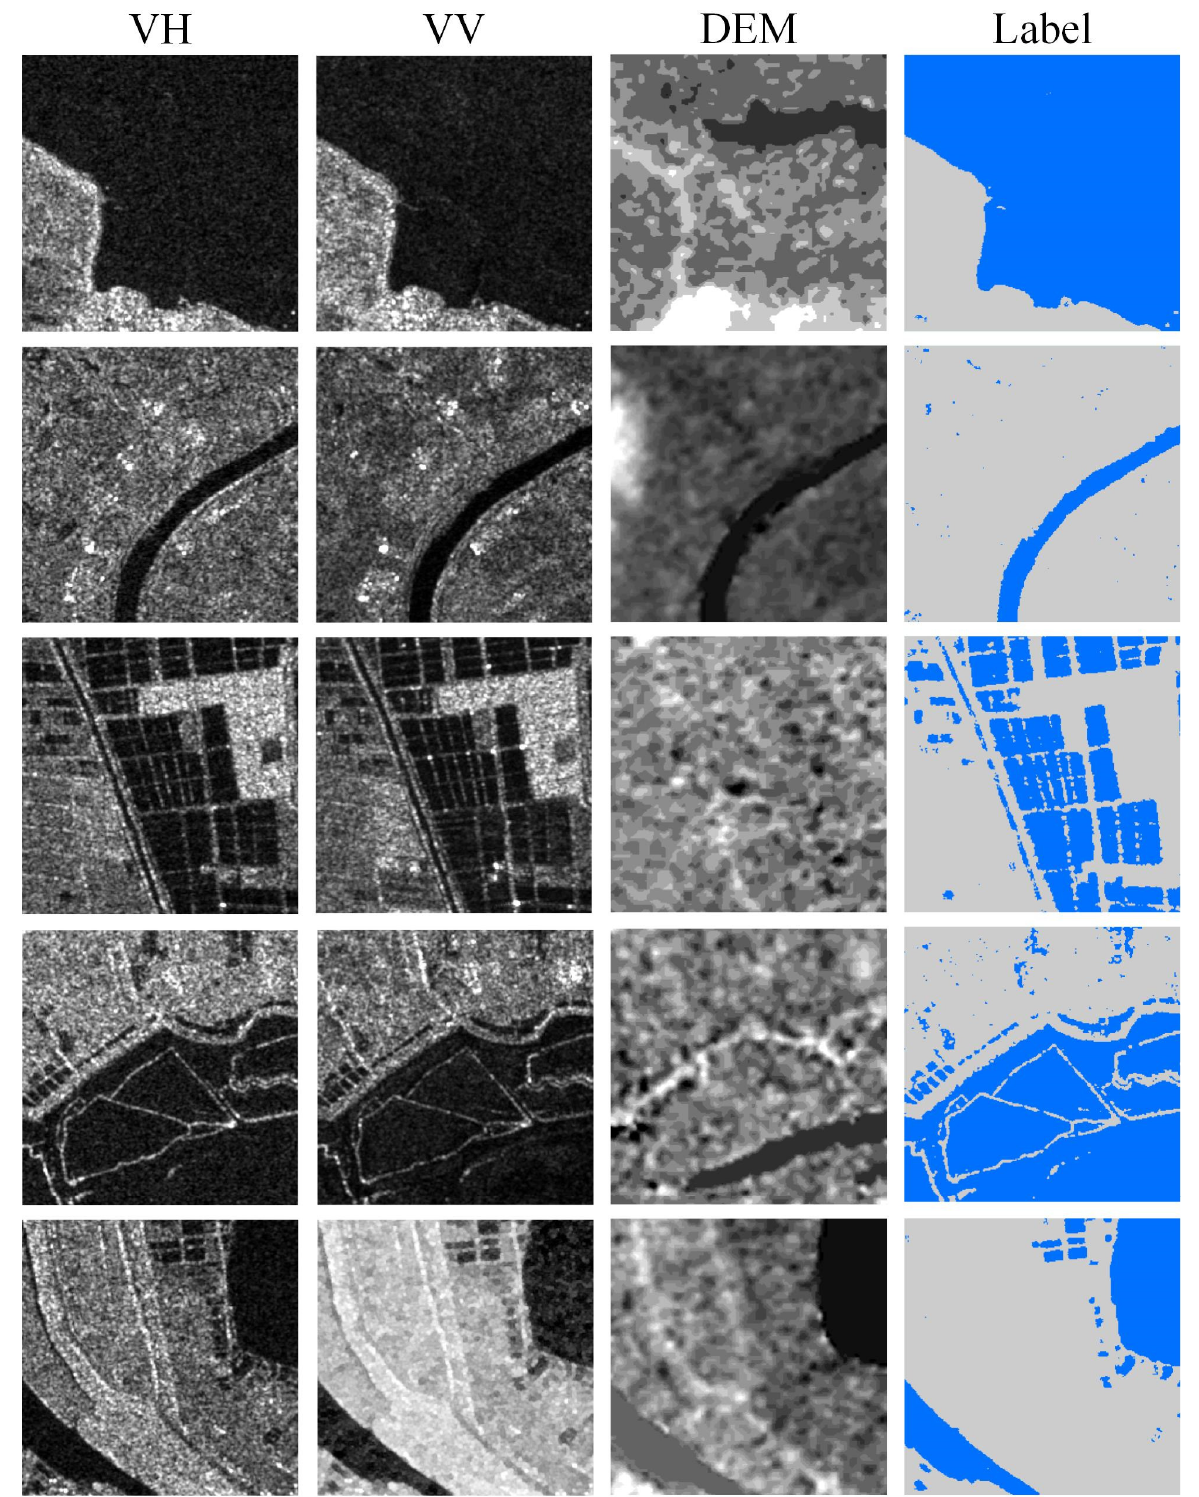
Figure 5. Examples of strong label dataset derived from present study.